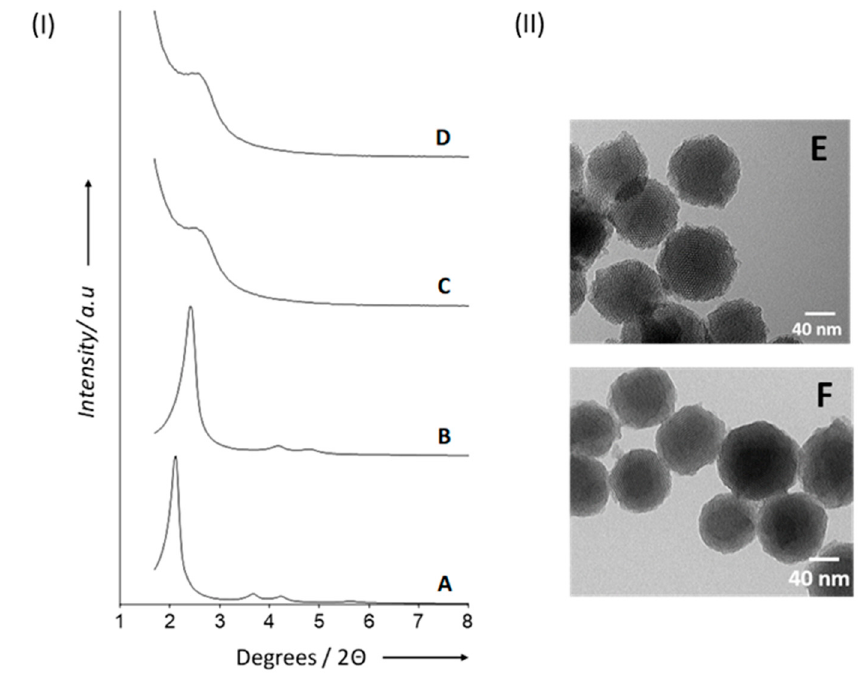
Figure 2. ( I ) Powder X-ray diffraction patterns of as-synthesized MSNs ( A ), calcined MSNs ( B ), solid S1 ( C ), and solid S2 ( D ). ( II ) TEM images of solids S2 ( E ) and S3 ( F ). Table 1. BET specific surface values, pore volumes, and pore sizes calculated. Solid